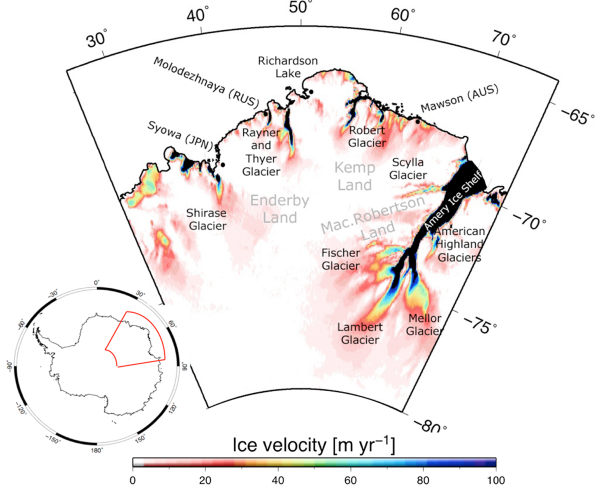
Figure 1. Regional map of our study area including Enderby Land, Kemp Land, and Mac.Robertson Land. The map includes the lo- cations of permanent research stations and major outlet glaciers. Ice velocity rates are plotted, sourced from the NASA MEaSUREs Program (Rignot et al., 2011; Mouginot et al., 2012), to identify glaciers and regions with dynamic ice